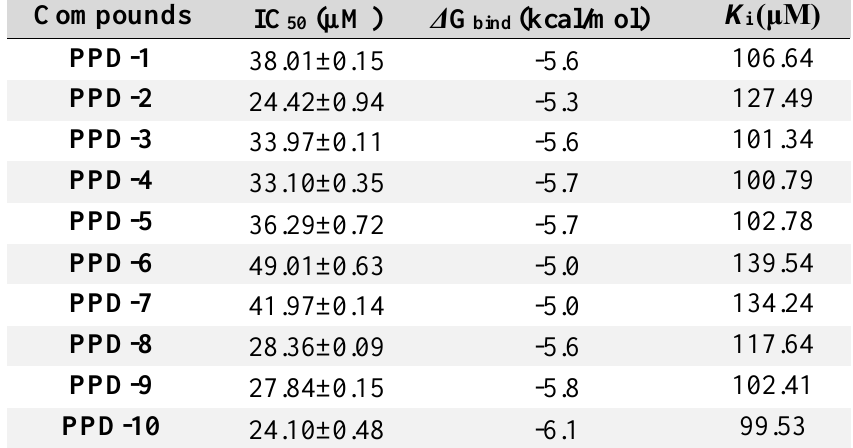
Results of IC 50 values represent mean values ± standard deviation (SD) of three independent